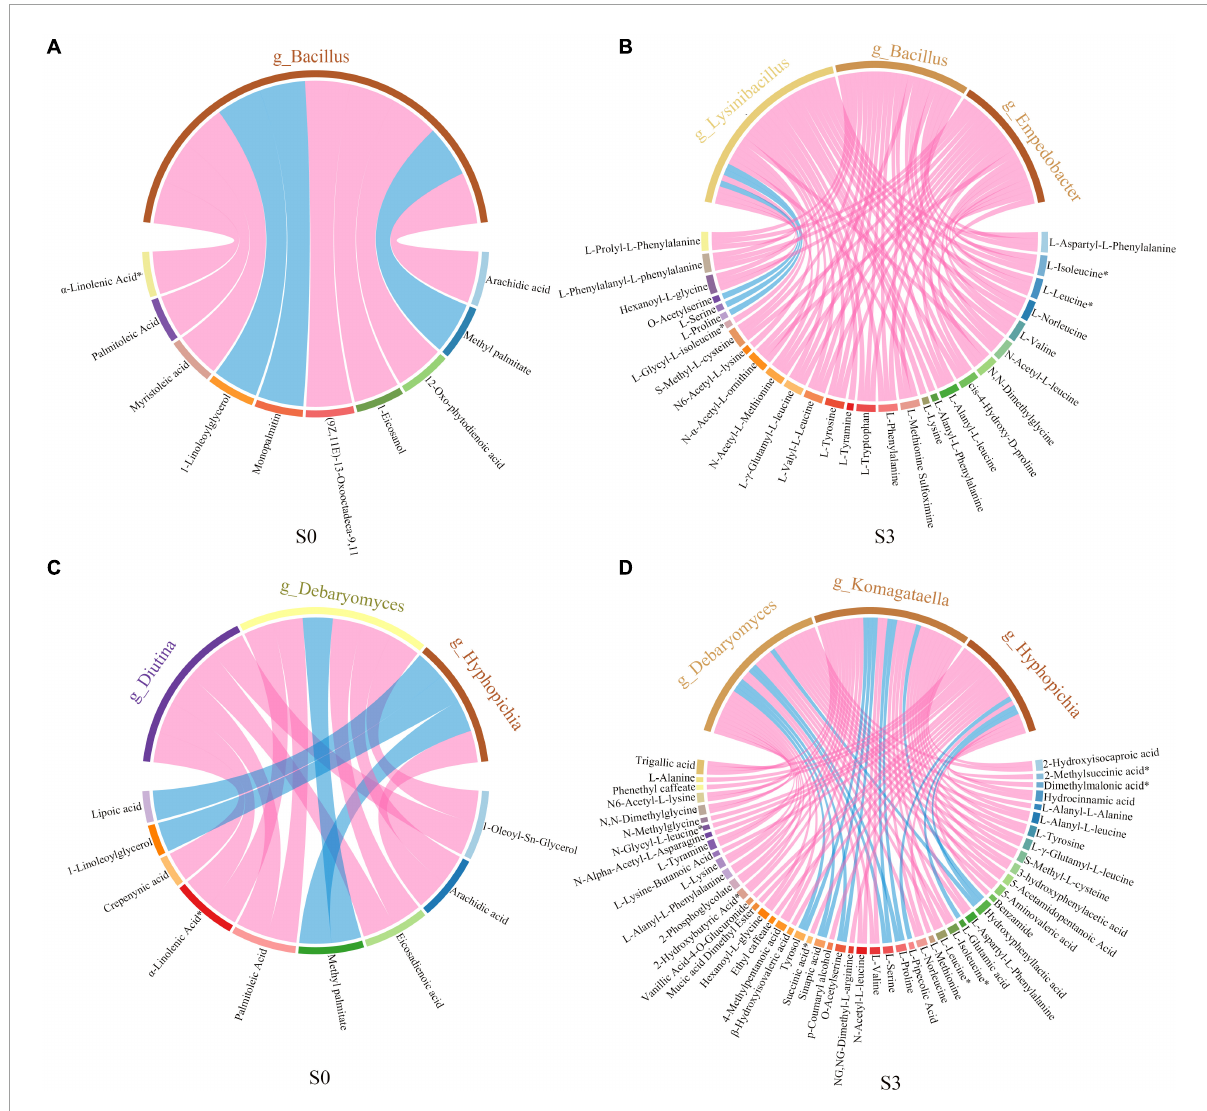
FIGURE8 Correlation chord diagram of microorganisms and metabolites. (A) Correlation chord diagram of bacteria and metabolites in S0. (B) Correlation chord diagram of bacteria and metabolites in S3. (C) Correlation chord diagram of fungus and metabolites in S0. (D) Correlation chord diagram of fungus and metabolites in